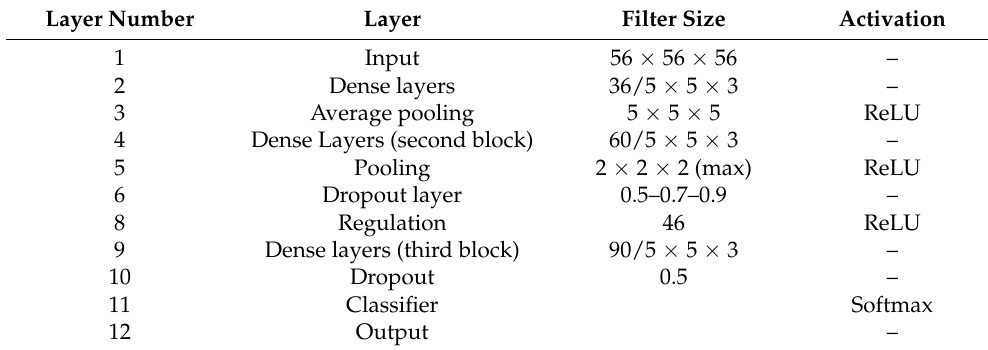
Table 5. CNN model layers and hyper-parameters.